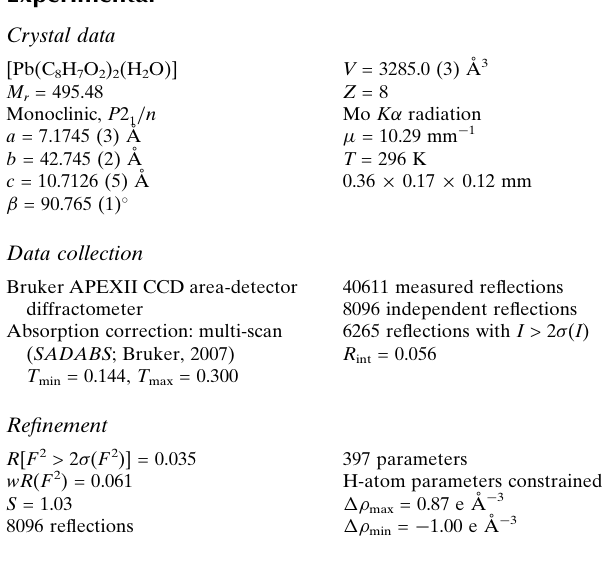
Key indicators: single-crystal X-ray study; T = 296 K; mean (cid:2) (C–C) = 0.009 A˚; R factor = 0.035; wR factor = 0.061; data-to-parameter ratio = 20.4.